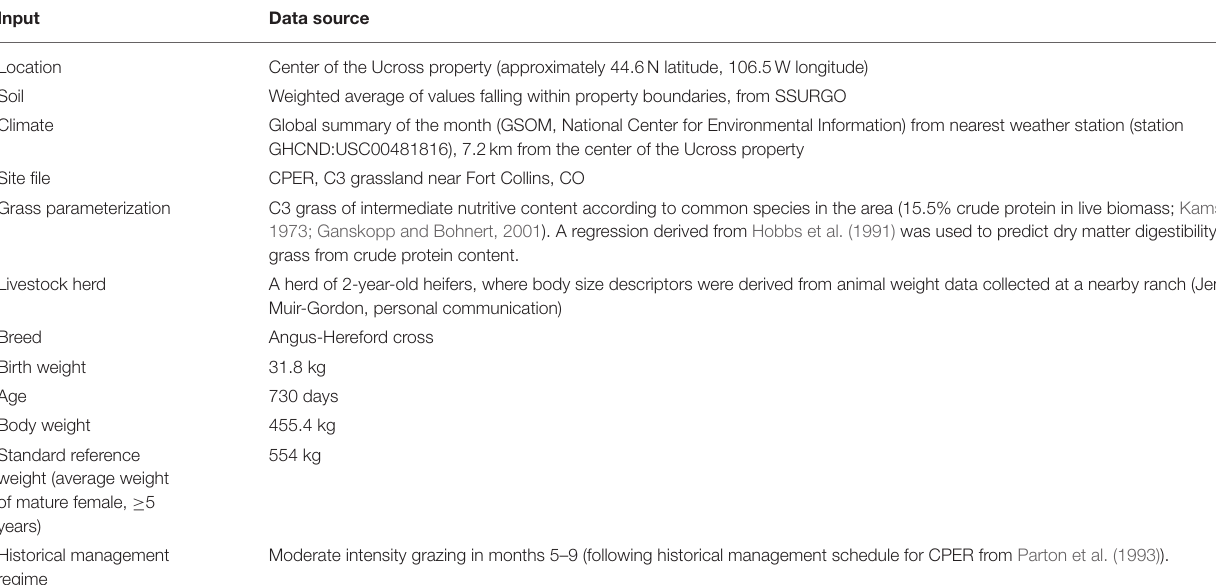
TABLE 3 | Model inputs and data sources representing the Middle Alkire pasture of the Ucross